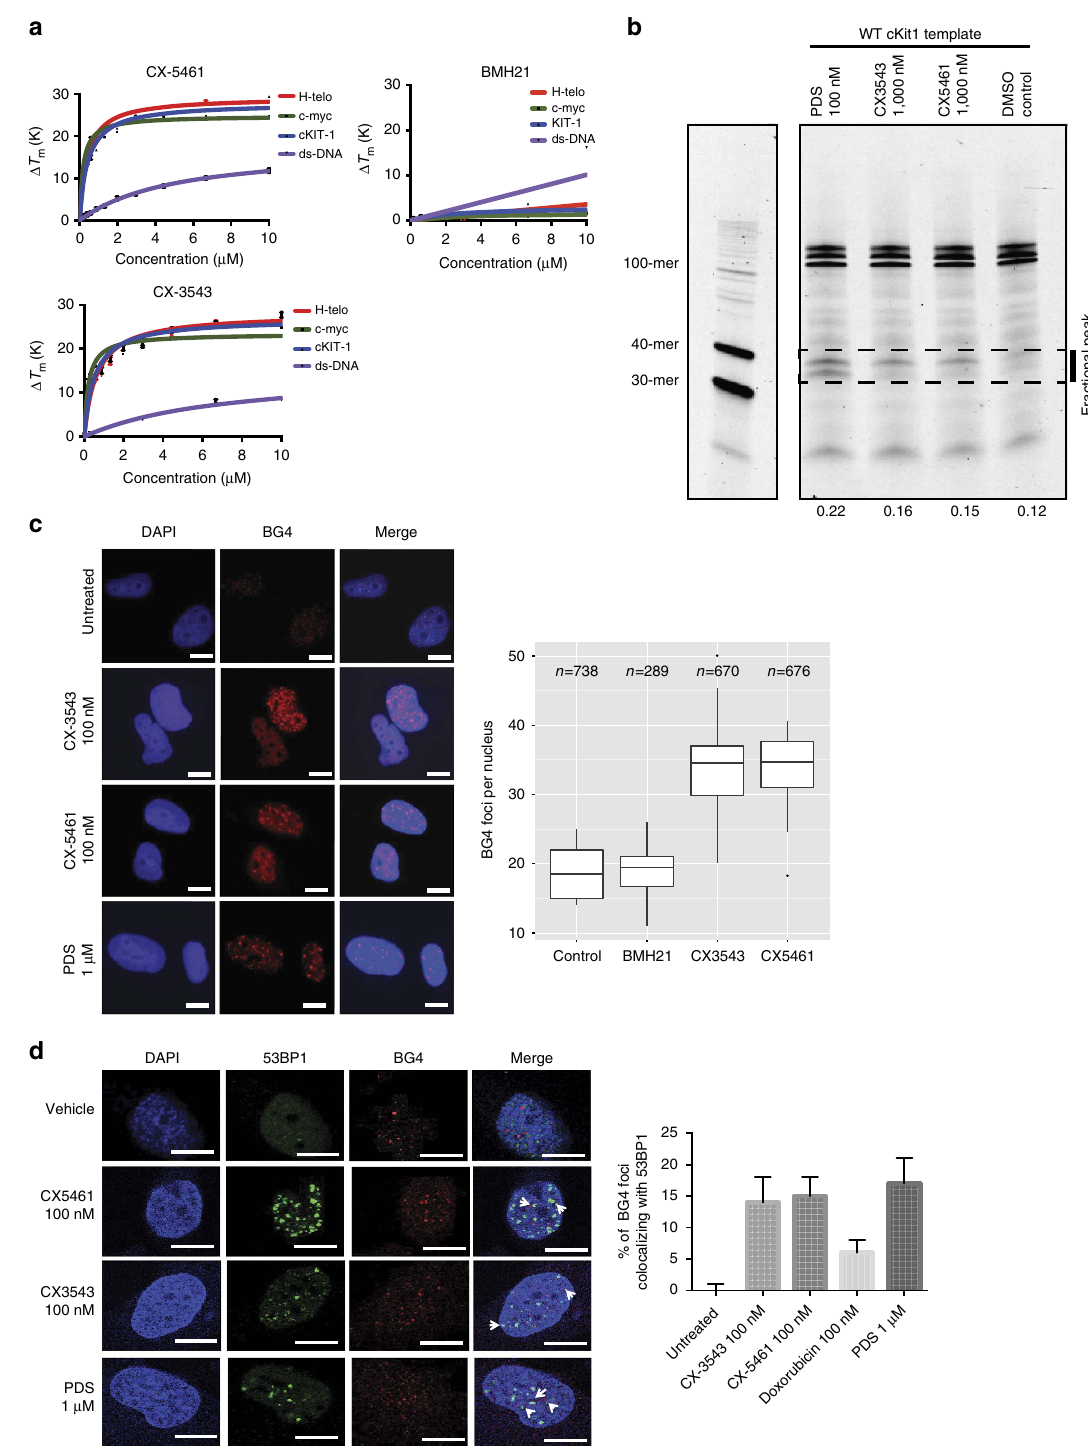
Figure 5 | CX-5461 and CX-3543 stabilize G4 sequences. ( a ) In vitro FRET melting assay with three different G4 forming DNA fragments and a non-G4 forming dsDNA control. Vertical axis, changes in melting temperature; horizontal axis, drug concentration ( m M). Error bars denote the s.d.; n ¼ 3. The solid lines represent the interpolation of the values with a single binding curve model. ( b ) Progression of DNA polymerase was stalled by CX-5461 and CX-3543 when incubating with G4 forming sequence cKit1. Full gel image is displayed in Supplementary Fig. 6c. ( c ) CX-5461 and CX-3543 bind to and stabilize G4 structure as demonstrated by the increased number of immunofluorescence foci with G4 binding antibody, BG4. Scale bar, 10 m M. Right panel shows the quantification. Median BG4 foci per nucleus is shown. The box extends from the 25th to 75th percentiles. ( d ) Co-localization between 53BP1 foci and BG4 foci. Drug treatment time is 24h, N ¼ 2. B 500 cells per condition were counted. Scale bar, 10 m M. Right panel shows the quantification. Error bars denote the